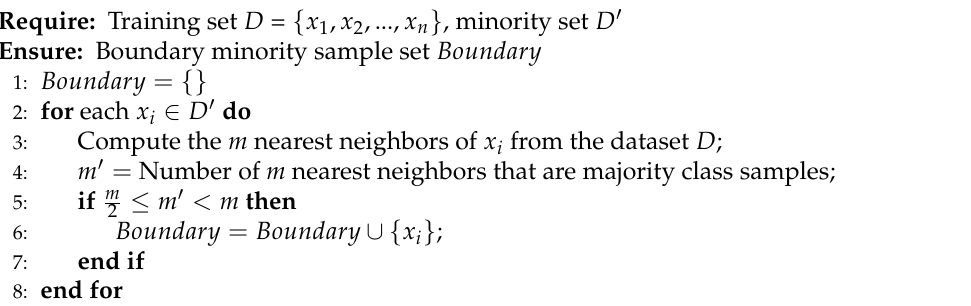
Algorithm 3 Boundary domain